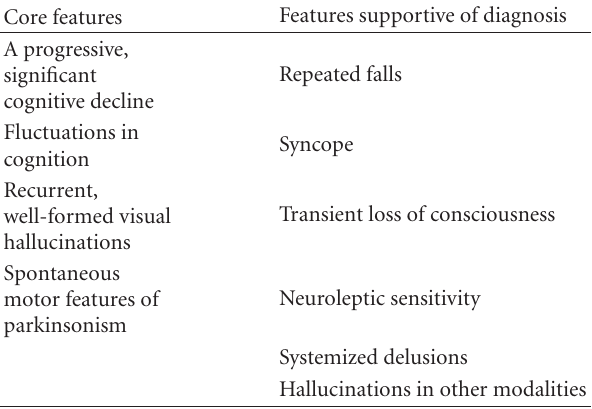
Table 1: Clinical diagnostic criteria for